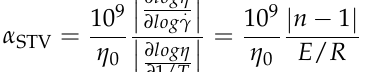
Figure 6. SEM images of fracture surfaces of green parts formed from various feedstocks: ( a ) FS-55; ( b ) FS-65; ( c ) FS-70. 3.2. Sintering Densification and Mechanical Properties The ball milled powder was extruded into ‘I’-shape tensile samples using FS-65 binder system at a powder loading of 50% (Named as W-Ni-Fe-5). For a comparison, the as-received powder was also extruded into ‘I’-shape tensile samples using FS-65 binder system at a powder loading of 40% (Named as W-Ni-Fe). Figure 7 shows relative density of the two kinds of powder varying with sintering temperature. It shows that the relative